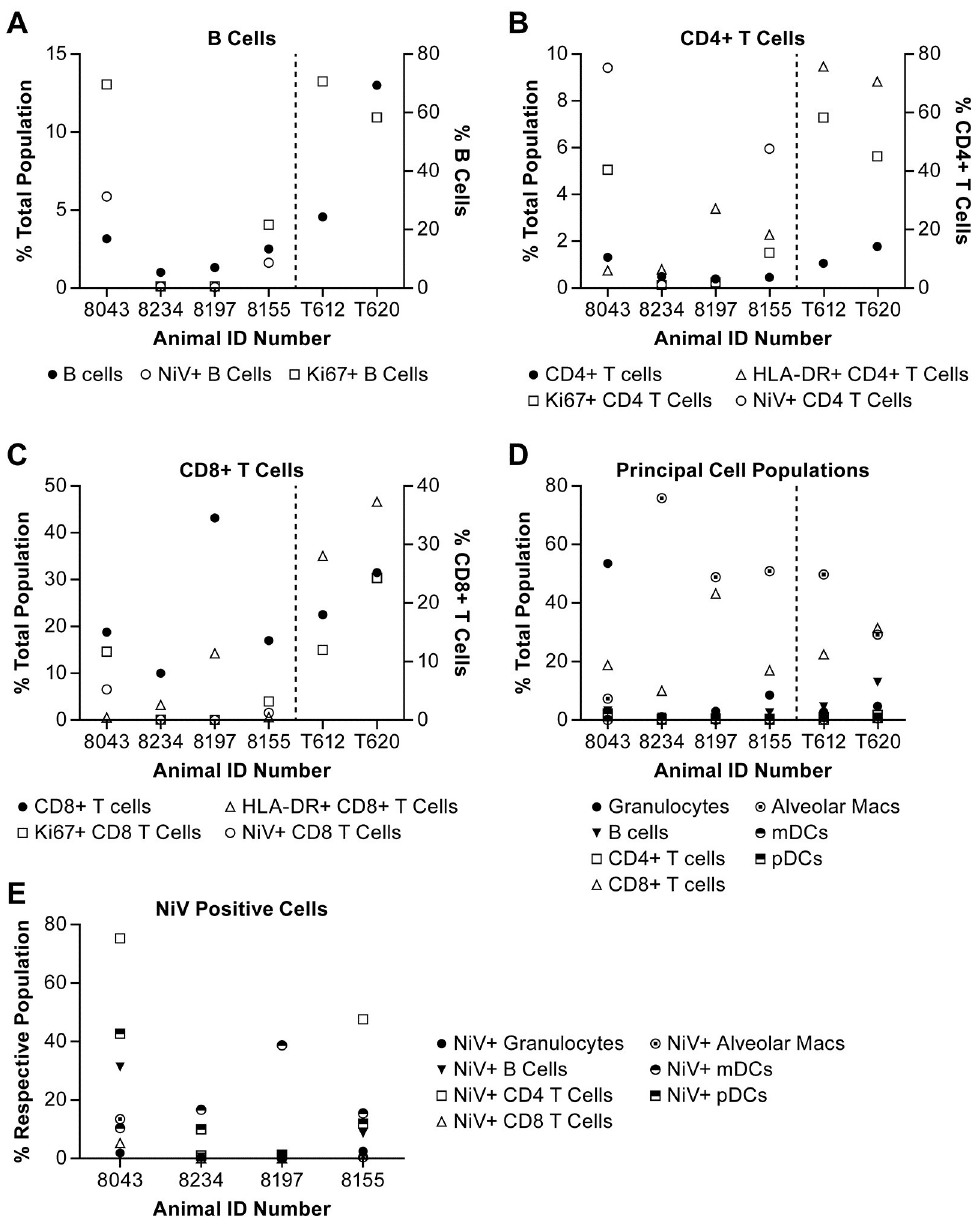
Fig 9. Immune cell populations in bronchoalveolar lavage. Flow cytometric analysis of BAL collected from animals immediately prior to necropsy. Samples were collected from four of six animals included in this study. Also included are data from two uninfected control animals (T612 and T620). Analysis focused on seven principal cell populations that were expected in the BAL and included the proliferation marker Ki67 and determination of the presence of NiV antigen using a virus glycoprotein (G) specific polyclonal antiserum [25]. Adaptive immune response cell populations evaluated included (A) B cells; (B) CD4+ T cells and (C) CD8+ T cells. The distribution of all cell populations evaluated in individual animals is provided in (D) and (E) shows which cell populations were NiV antigen